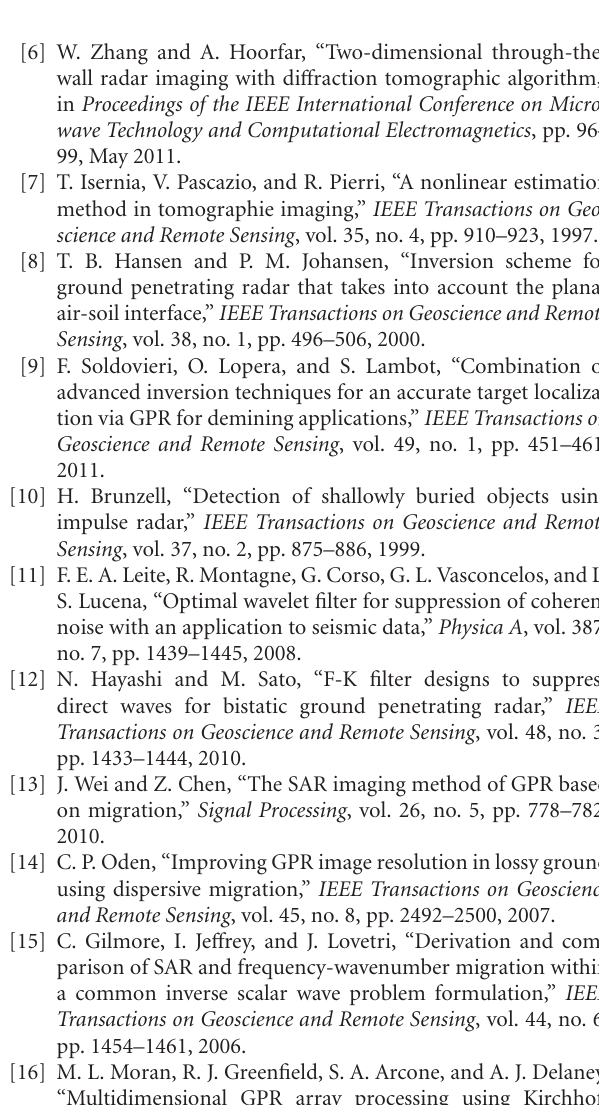
Figure 8: Image obtained with the GPR radar scattered field data by TR-MUSIC algorithm; colors represent the pseudospectrum value: (a) on the scattered data without migration procedure; (b) on the scattered data after migration